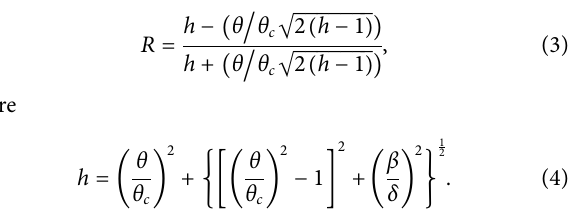
FIGURE 4 | Schematic diagram of X-rays incident on the SBC. (A) X-rays from the point source are incident on the SBC. (B) X-rays from the planar source are incident on the